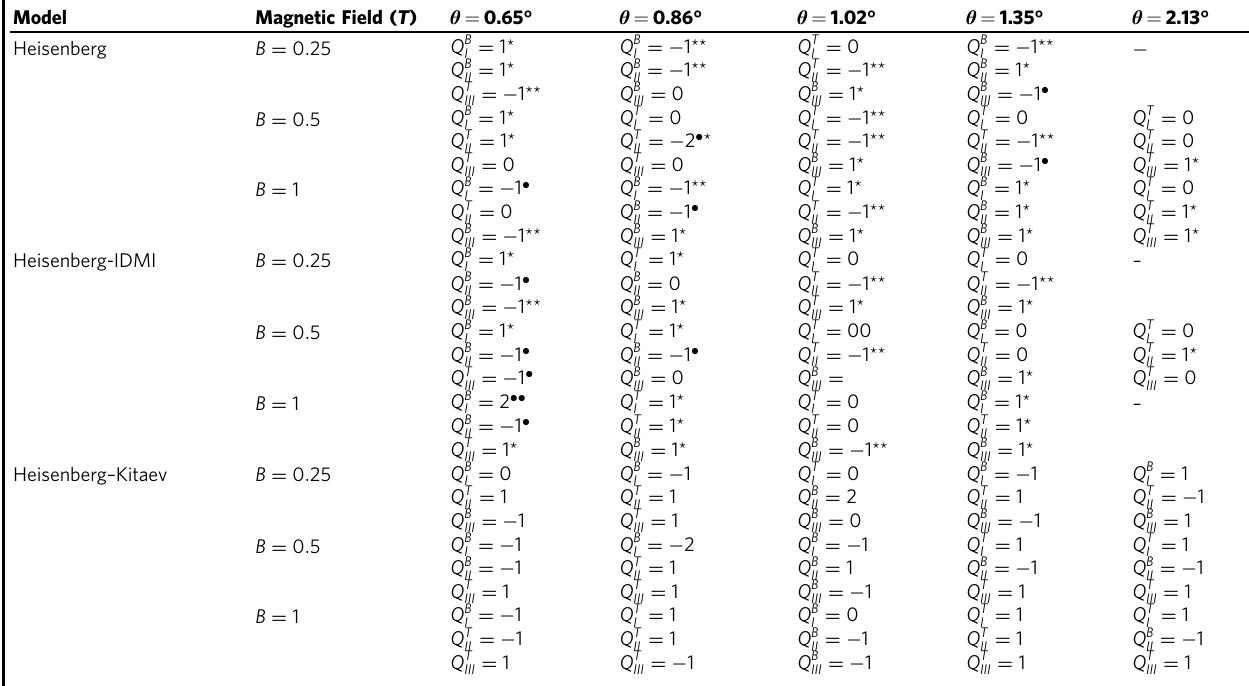
The table elaborates the rich spectrum of fi eld-assisted TSTs in the nonchiral models, presenting selected results from several simulations with distinct random initial states as described in the text. The symbols θ and B stand for the twist angleand the magnitude of the external magnetic fi eld, respectively. We have calculatedthe topologicalcharge Q from Eq. (1),usingthe numericalalgorithm detailed by M. Augustin et al. 50 (see their supplementary materials for full details). The subscript of Q speci fi es the antiferromagnetic region to which the TST is con fi ned. The superscripts B and T stand for the bottom( l ¼ 1)andtop( l ¼ 2)layers,respectively.IDMIstandsfortheintrinsicDzyaloshinskii – Moriyainteraction.IntheHeisenbergandthe Heisenberg-IDMImodels,thesymbolnexttothetopological charge indicates the TST ’ s nature. We used the following conventions: antiskyrmion*, Bloch-type skyrmion**, Néel-type skyrmion (cid:129) , antiskyrmion pair (cid:129)(cid:129) , and skyrmion pair (cid:129) *. In the Heisenberg – Kitaev model, the TSTs are identi fi ed as vortices ð Q < 0 Þ and antivortices ð Q > 0 Þ . The dashes indicate the absence of